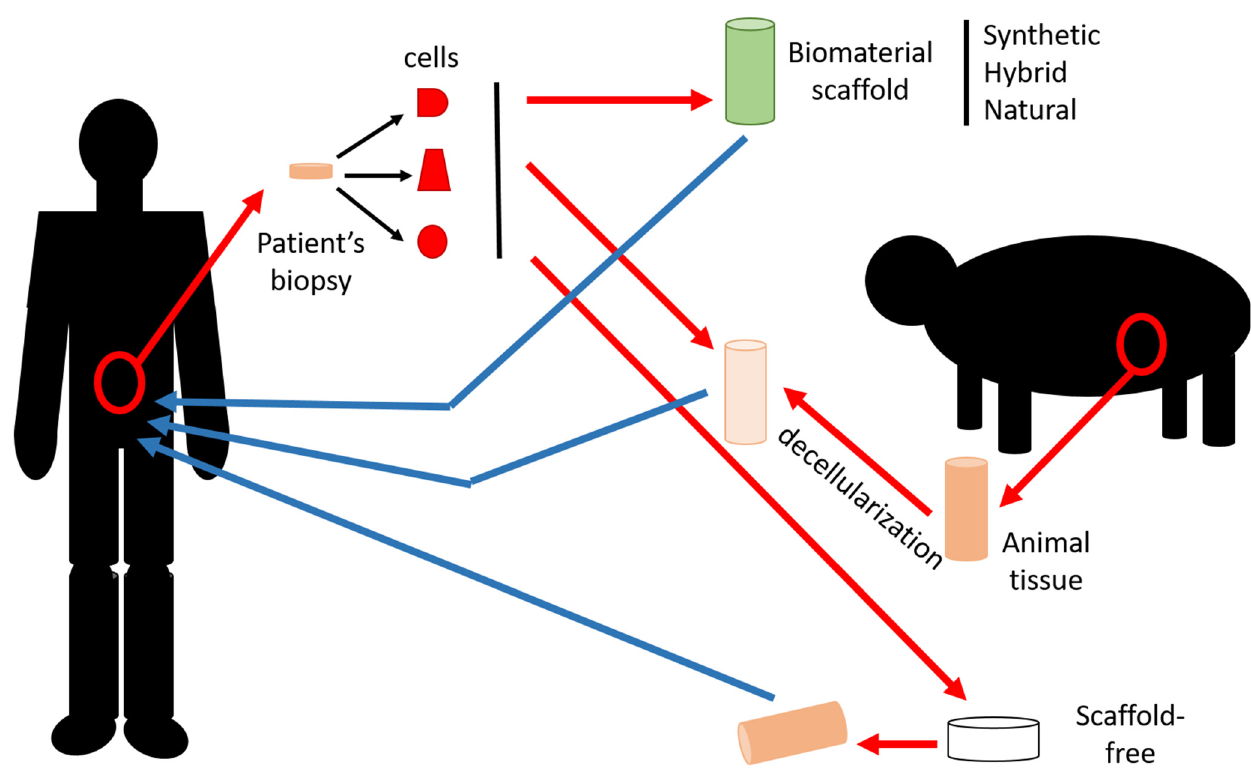
Figure 1. Strategies to engineer tissues. Cells are usually harvested from the target organ to re- pair/replace or from an organ playing a similar role in the patient. Cell populations can be isolated after extraction or sometimes used mixed. These cells can be seeded onto synthetic, hybrid or natural biomaterial scaffolds produced by different techniques. Alternatively, cells can be seeded onto acellular matrices used as a scaffold. If no scaffold is used, cells can be seeded onto cell culture support and grown in the presence of ascorbate to produce their extracellular matrix. Once the tissue is cell-seeded and matured in a bioreactor, the resulting tissue can be implanted in the patient to repair/replace their failing organ.